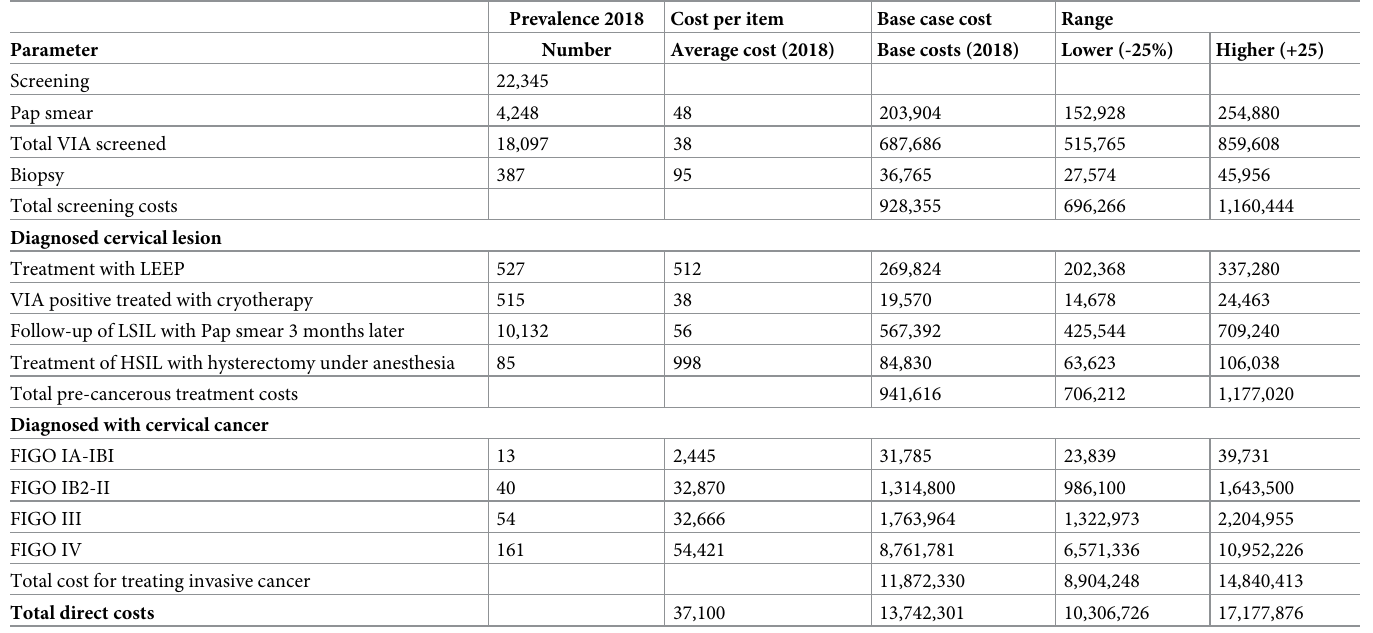
Table 5. Annual direct (health care costs) cost estimation for prevention, management and treatment of cervical cancer lesions and cancer expressed in $ for 2018.